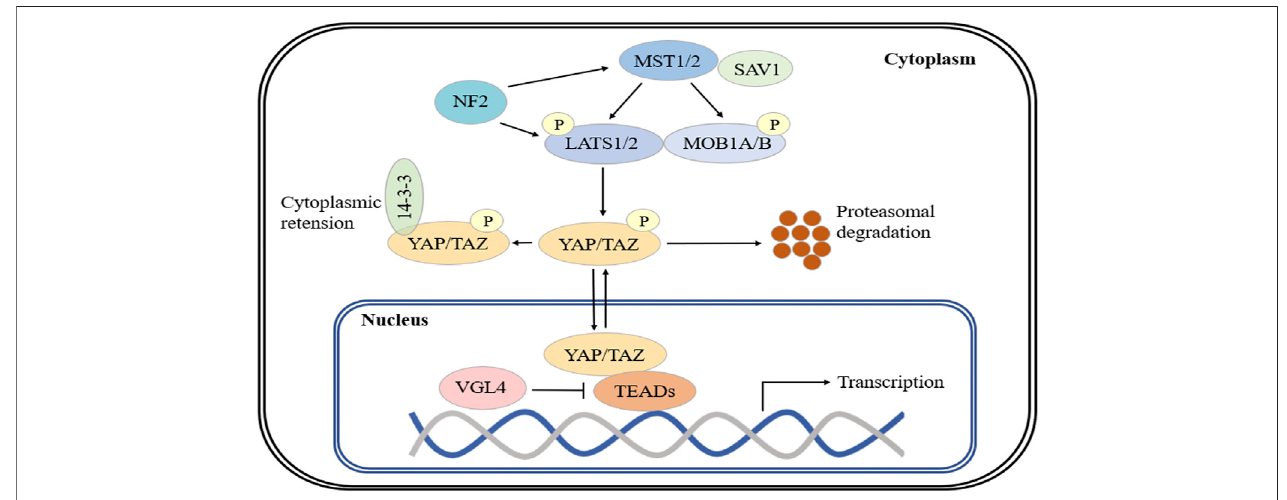
FIGURE 1 | The Hippo signaling pathway. Major mammalian Hippo signaling pathway components. When the Hippo pathway is active, MST1/2 activates and phosphorylatesMOB1A/BandLATS1/2,andactivatedLATS1/2phosphorylatesYAPandTAZ.PhosphorylatedYAP/TAZissequesteredinthecytoplasmbybindingto 14-3-3proteinandisdegradedby β -TrCP.IntheabsenceofHipposignaling,inactiveLATS1/2cannotphosphorylateYAP/TAZ,andYAP/TAZtranslocatetothenucleus and interact with TEAD transcription factors to promote target gene expression. VGL4 competes with YAP for TEAD binding. NF2 directly interacts with LATS1/ 2 and induces its